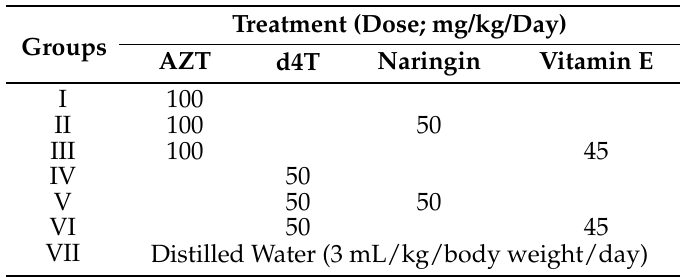
Table 1. Animal treatment